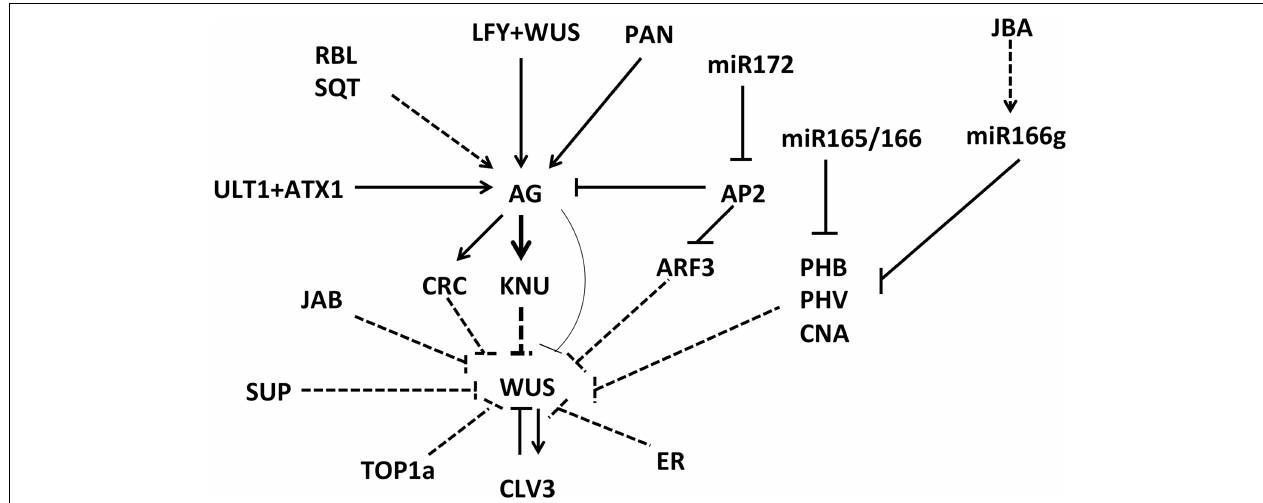
FIGURE 2 | Various factors involved in floral meristem control. Many regulators control the expression of the stem cell identity gene WUS in direct and indirect ways. Solid lines indicate direct activation or repression, and dashed lines indicate a proposed type of regulation that has yet to be confirmed.